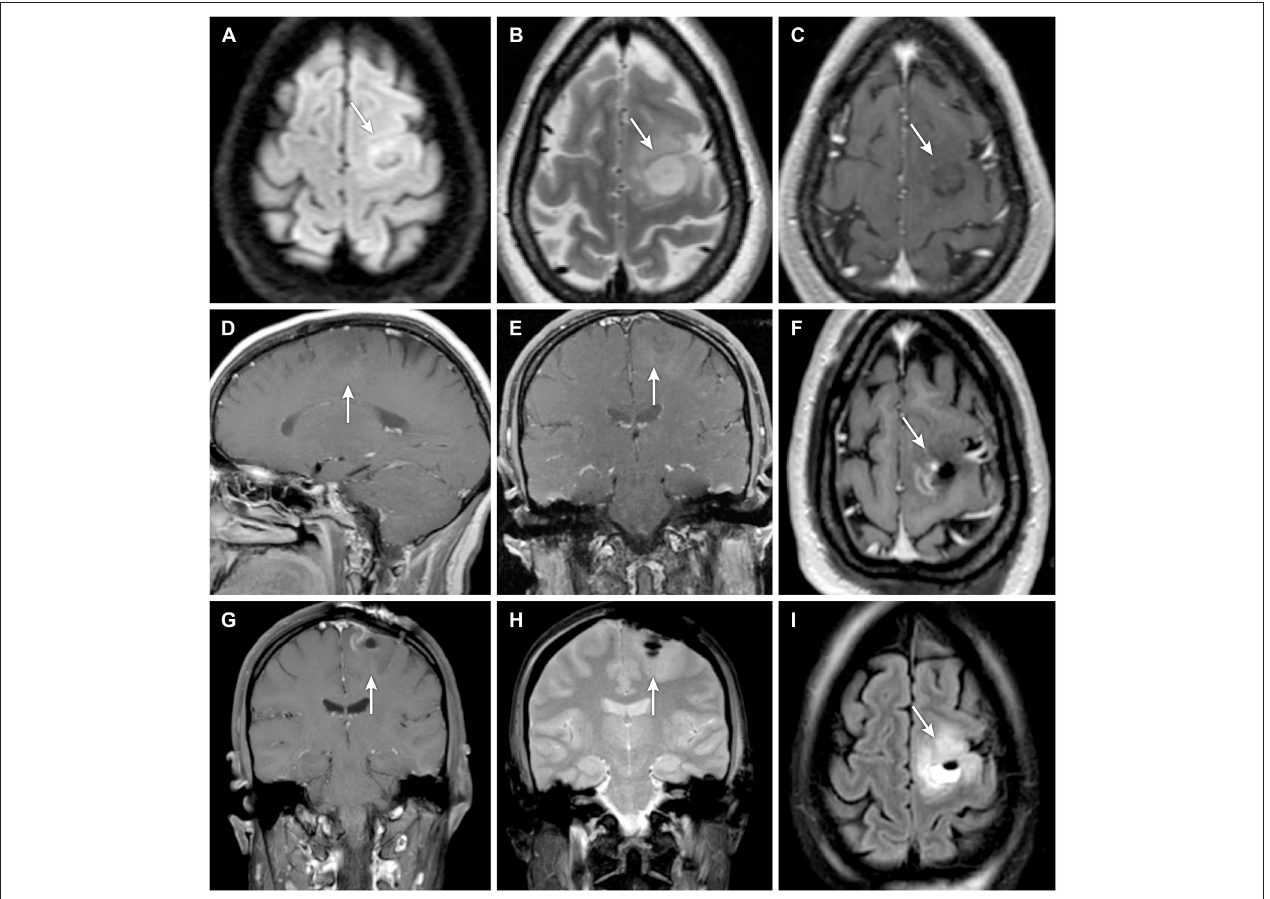
FIGURE 1 | (A–E) Preoperative and (F–I) postoperative magnetic resonance imaging (MRI) of a patient with a nonenhancing lesion ( A–I , arrows ) in the left precentral gyrus. Preoperative MRIs shown are (A) axial diffusion-weighted, (B) axial T2-weighted, (C) axial T1-weighted, (D) sagittal T1-weighted with contrast, and (E) coronal T1-weighted with contrast. Postoperative MRIs shown are (F) axial T1-weighted with contrast, (G) coronal T1-weighted with contrast, (H) coronal diffusion-weighted, and (I) axial diffusion-weighted. Used with permission from Barrow Neurological Institute, Phoenix,